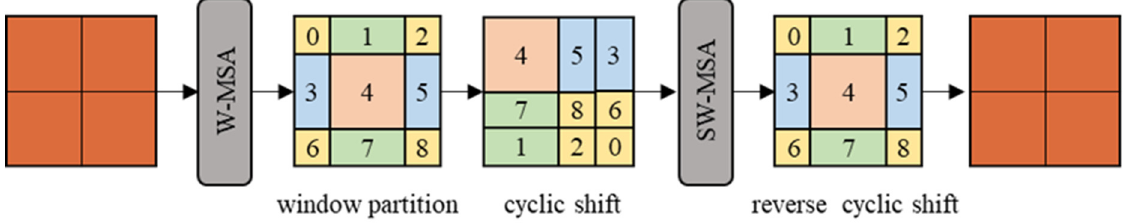
Figure 6. The illustration of the shifted window approach.